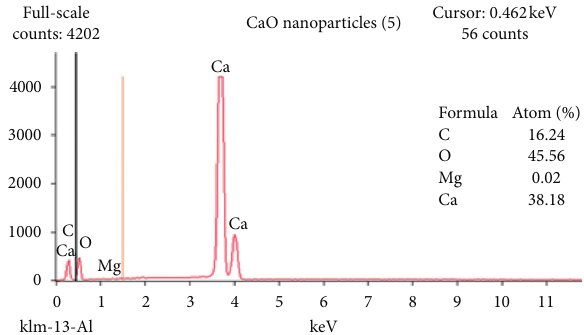
Figure 10: SEM-EDX analysis of CaO-NPs which were calcined at 800 ° Table 2: Physiochemical properties of mongongo nut oil and its methyl esters from eggshell ash and CaO-NPs. Properties